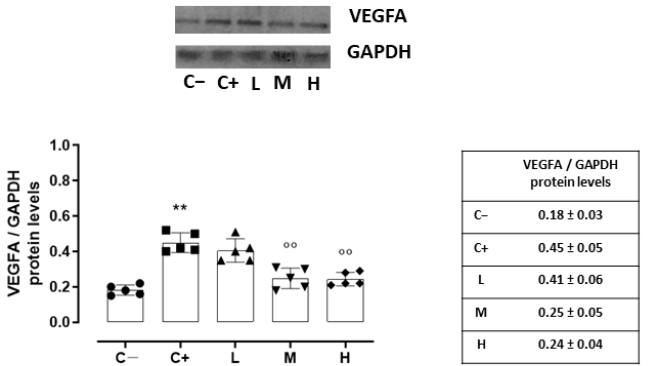
Figure 6. Representative Western blot images for corneal VEGFA and GAPDH, with relative quanti- zation (both VEGFA and GAPDH values were detected as densitometric units ± SD) in the TSP-1 KO mice euthanized at 6 weeks of age as a negative control for SS-associated dry eye (C − ); TSP-1 KO mice euthanized at 12 weeks of age as a positive control for SS-associated dry eye (C+); and TSP-1 KO mice supplied with low (L), medium (M), and high (H) doses of vitamin D3 (1000, 8000, and 20,000 IU/kg/week, respectively) from week 6 to week 12 of age. N = 7 corneas per group; EP: corneal epithelium. N = 5 corneas per group. ** p < 0.01 vs. C − ; ◦◦ p < 0.01 vs. C+.